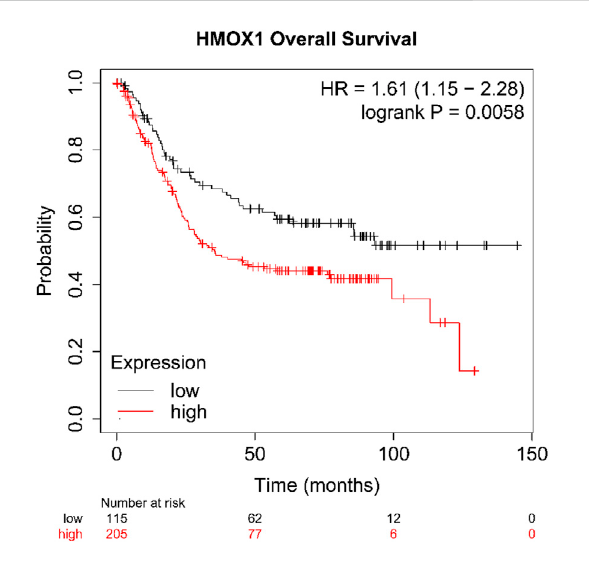
FIGURE 8 The survival analysis of HMOX1 ( p < 0.05; HR = 1.61).